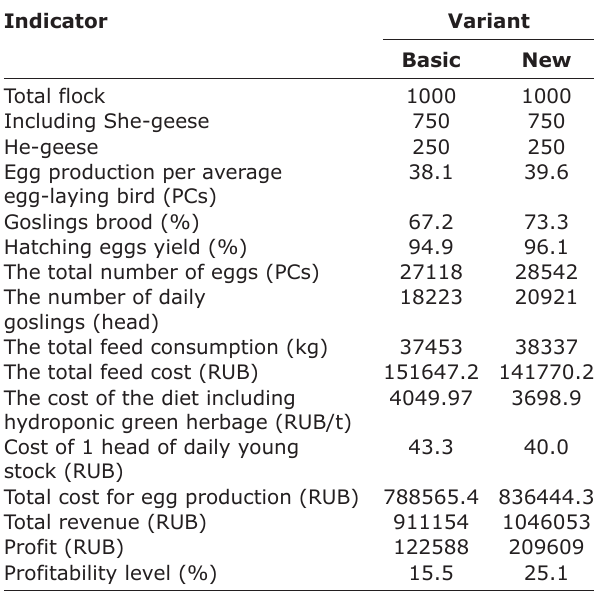
Table-2: Effectiveness of the hydroponic green herbage use in the parent flock geese diet.